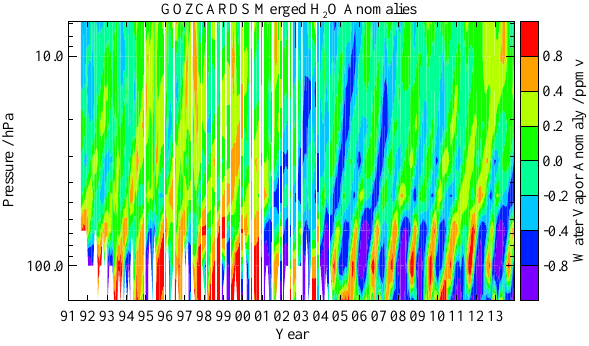
Figure 12. A depiction of the “tape recorder” evolution for tropi- cal water vapor abundances from 147 to 6.8hPa for October 1991 through December 2013. This plot was produced from GOZ- CARDS merged H 2 O time series anomalies (differences from the long-term means) for the average of the four tropical bins covering 20 ◦ S to 20 ◦